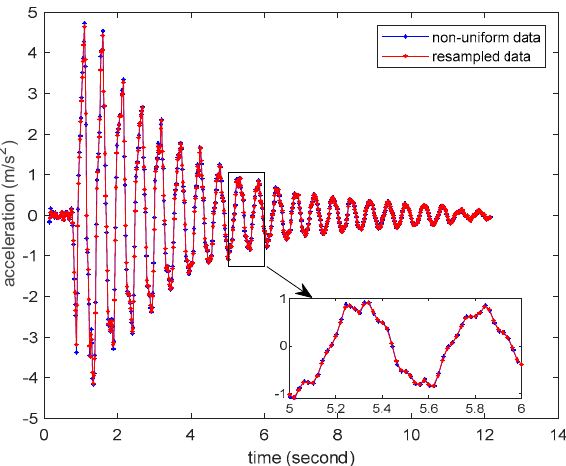
Figure 11. Comparison of measured non-uniformly distributed structural response and resampled uniformly distributed structural response.